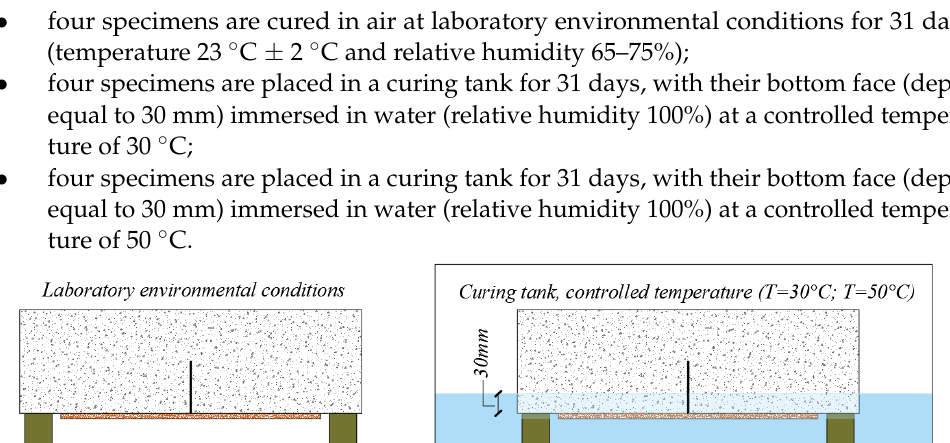
Figure 6. Notched concrete beams tested in three-point bending under displacement-controlled mode.